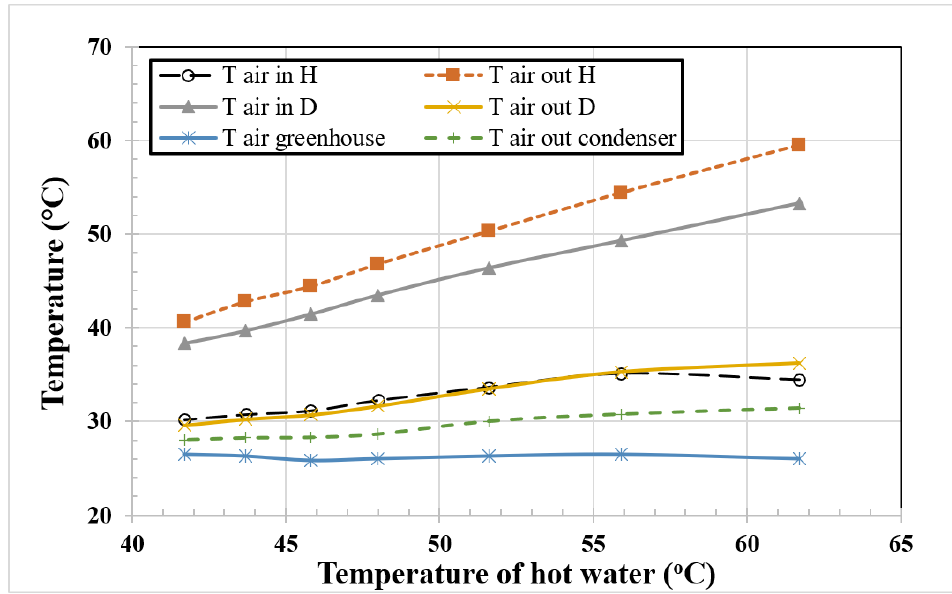
Figure 9. Air temperature profile in different parts of the system versus hot seawater temperature.